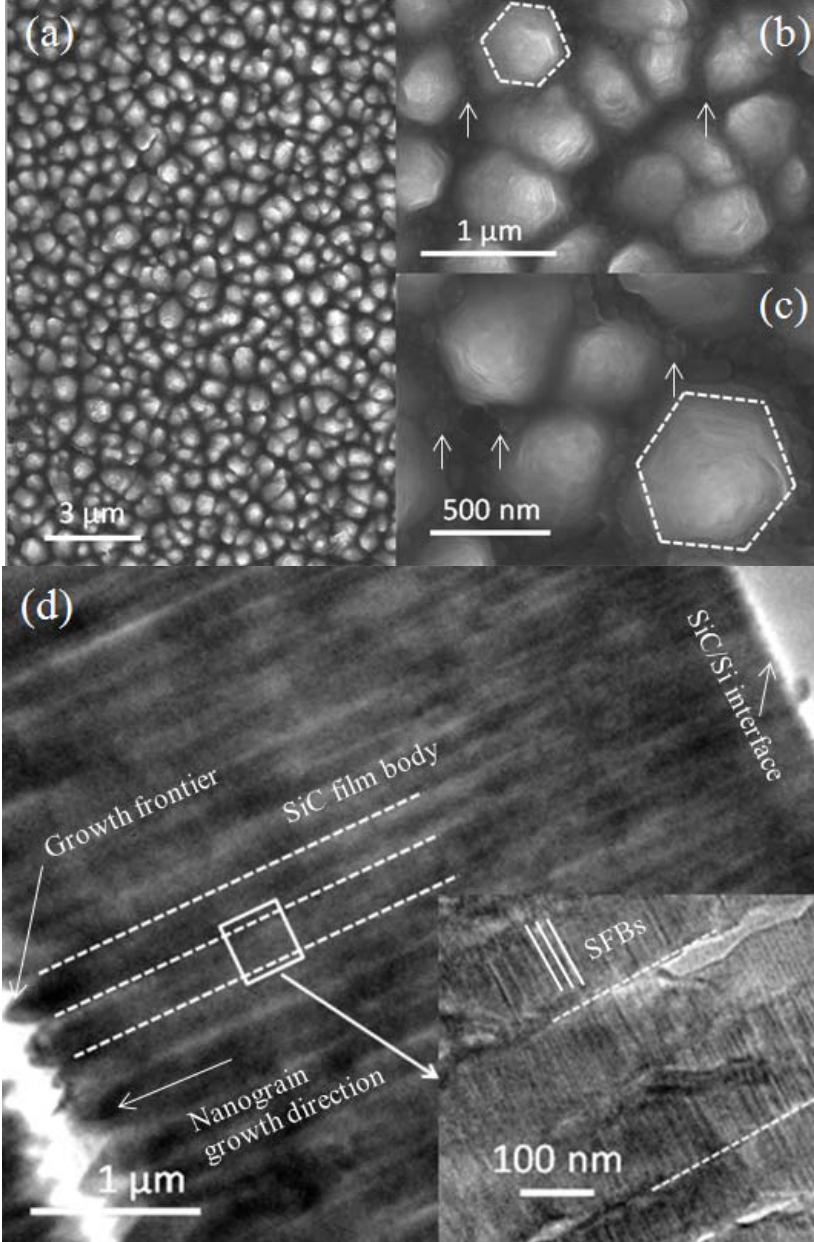
Figure 3. (a) Field-emission scanning electron microscopy (FESEM) image of surface morphologies of SiC films; (b,c) magnified images of (a). The dotted white hexagonal shapes are guides to the eye, and the white arrows in ( b ) and ( c ) point to spacers and GGNs between SiC nanograins, respectively; (d) TEM image of cross-sectional morphologies of SiC films. The right-bottom corner of ( d ) shows a magnified image of the nanograins. The parallel dotted white lines are guides to the